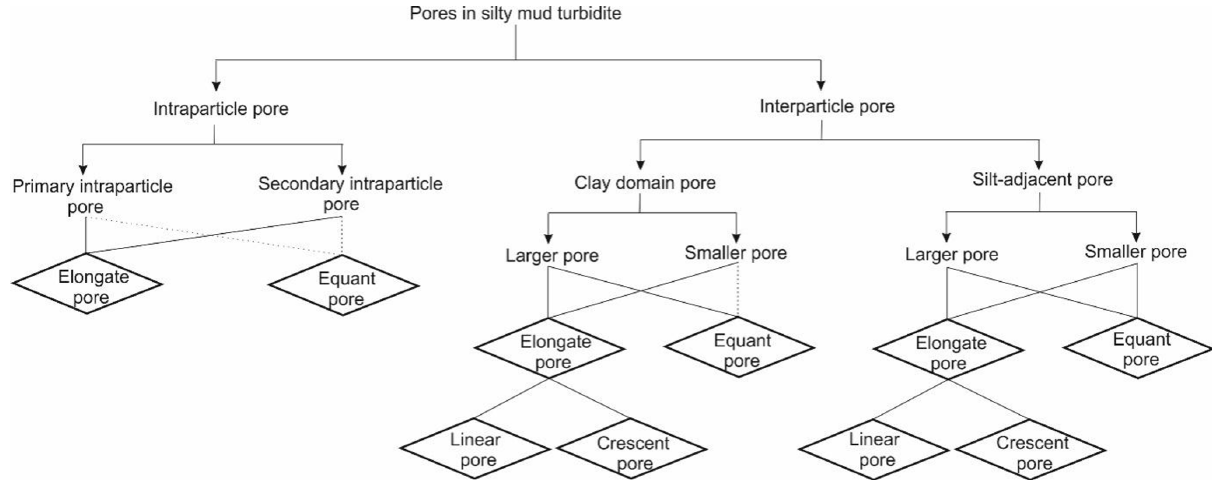
Figure 4. Classification scheme adopted to demonstrate pore reduction mechanics with increasing compactional strain. Dashed lines indicate rare pore